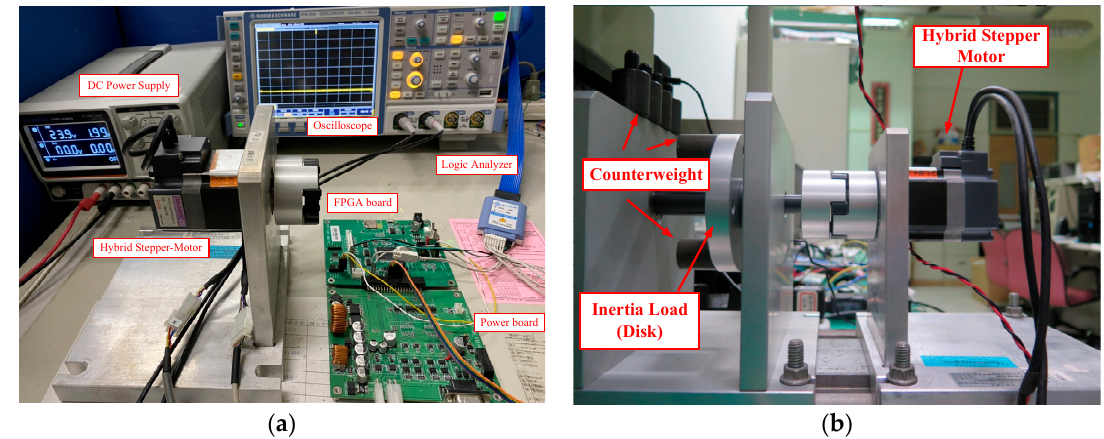
Figure 15. The setup and load for experiment. ( a ) The FPGA board, power board and stepper motor; ( b ) stepper motor and flywheel load.